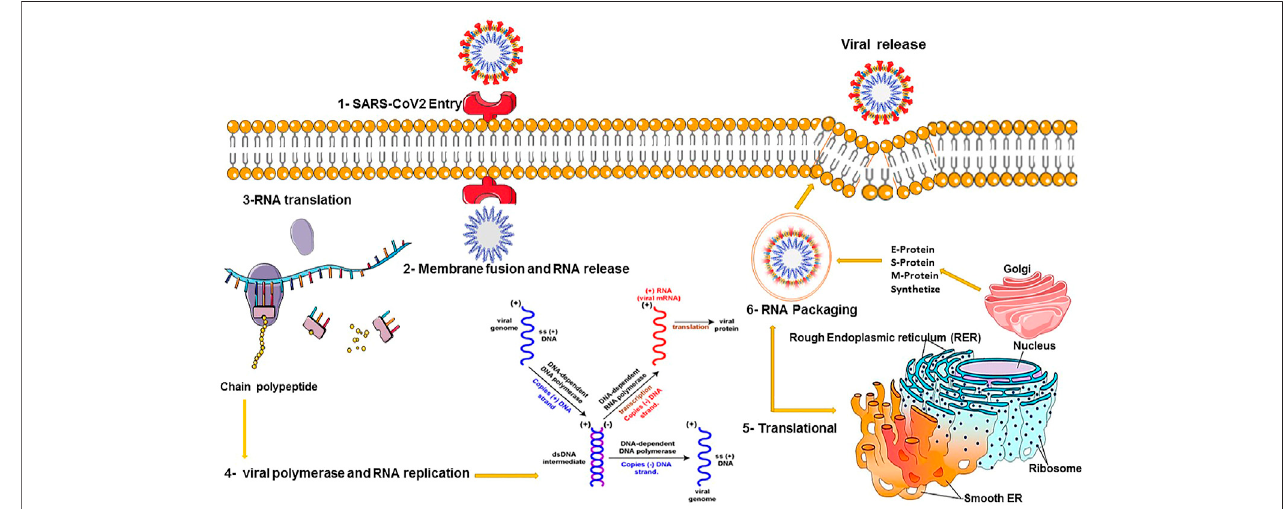
FIGURE 2 | COVID-19 viral replication and translation.